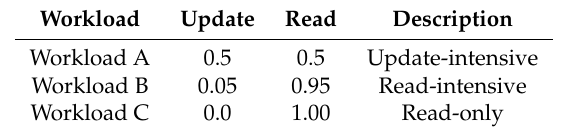
Table 2. The operation composition of Yahoo Cloud Service Benchmark (YCSB) workloads.